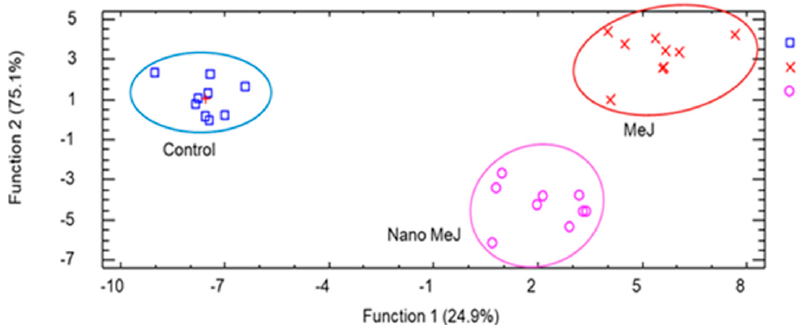
Figure 2. Canonical discriminant analysis used to classify the wines by treatments .